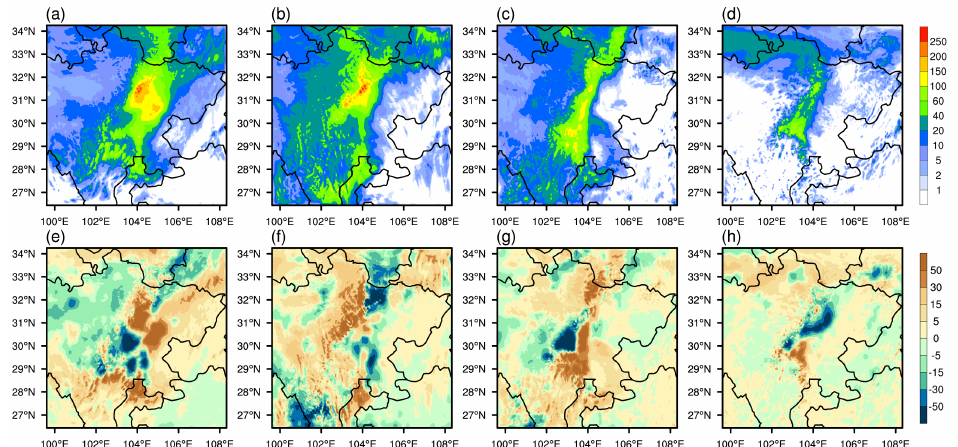
Figure 5. ( a – d ) show the ensemble mean of predicted 24-h accumulated precipitation (mm) for Case1 to Case4 respectively. ( e – h ) are the bias (mm) between WRF ensemble mean and observation.